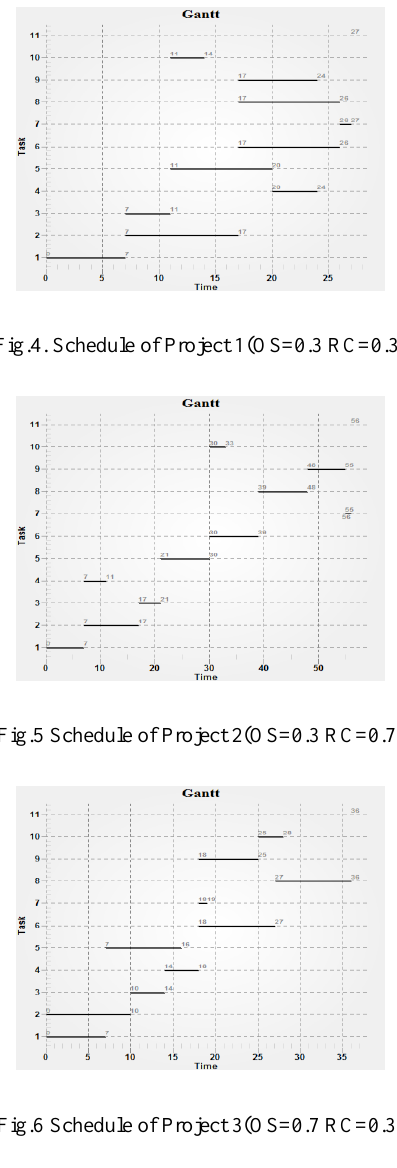
Fig.7 The basic structure of NSGA-II based solution